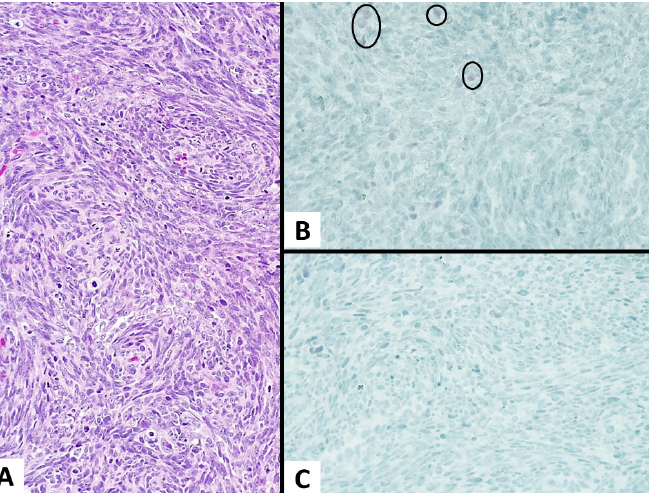
In contrast, the SMs were all negative for Claudin-4 and showed a BAP1 loss in 56.1% (23/41) of the cases, varying from 53.6% (15/28) of sarcomatoid mesotheliomas to 61.5% (8/13) of desmoplastic mesotheliomas (Figure 2).